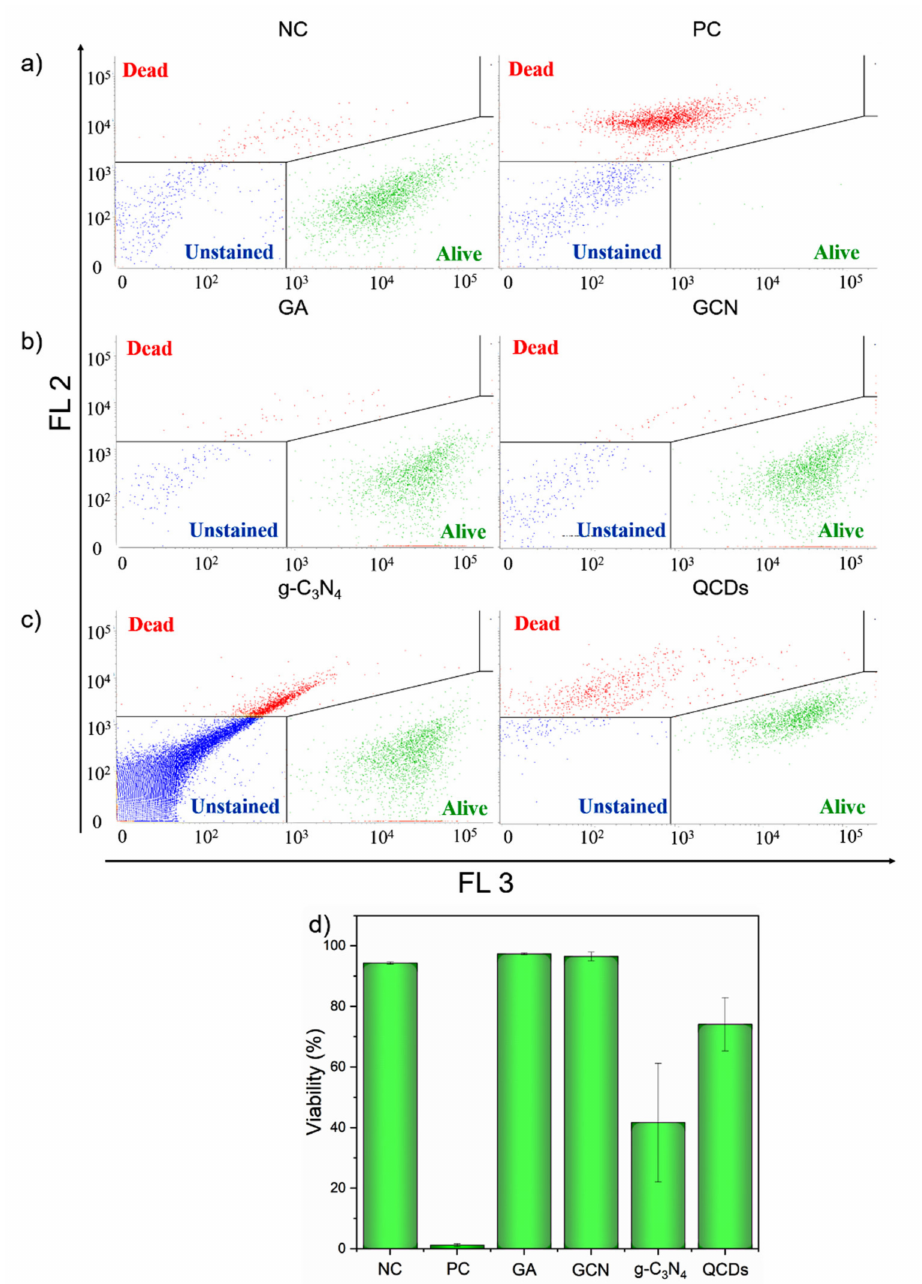
Figure 3. Dot plot showing LIVE/DEAD assay of: ( a ) negative and positive control of BJ cells; ( b ) BJ cells spike-in controls for GA ( left ) and GCN ( right ) and ( c ) BJ cells spike-in controls for g-C 3 N 4 ( left ) and QCDs ( right ). Gates were selected according to the NC and PC samples. ( d ) The evaluation of the viability of spike-in controls’ samples ( n = 3). The events in the alive gate are shown in green, events in the dead gate in red and events in the unstained gate are highlighted in